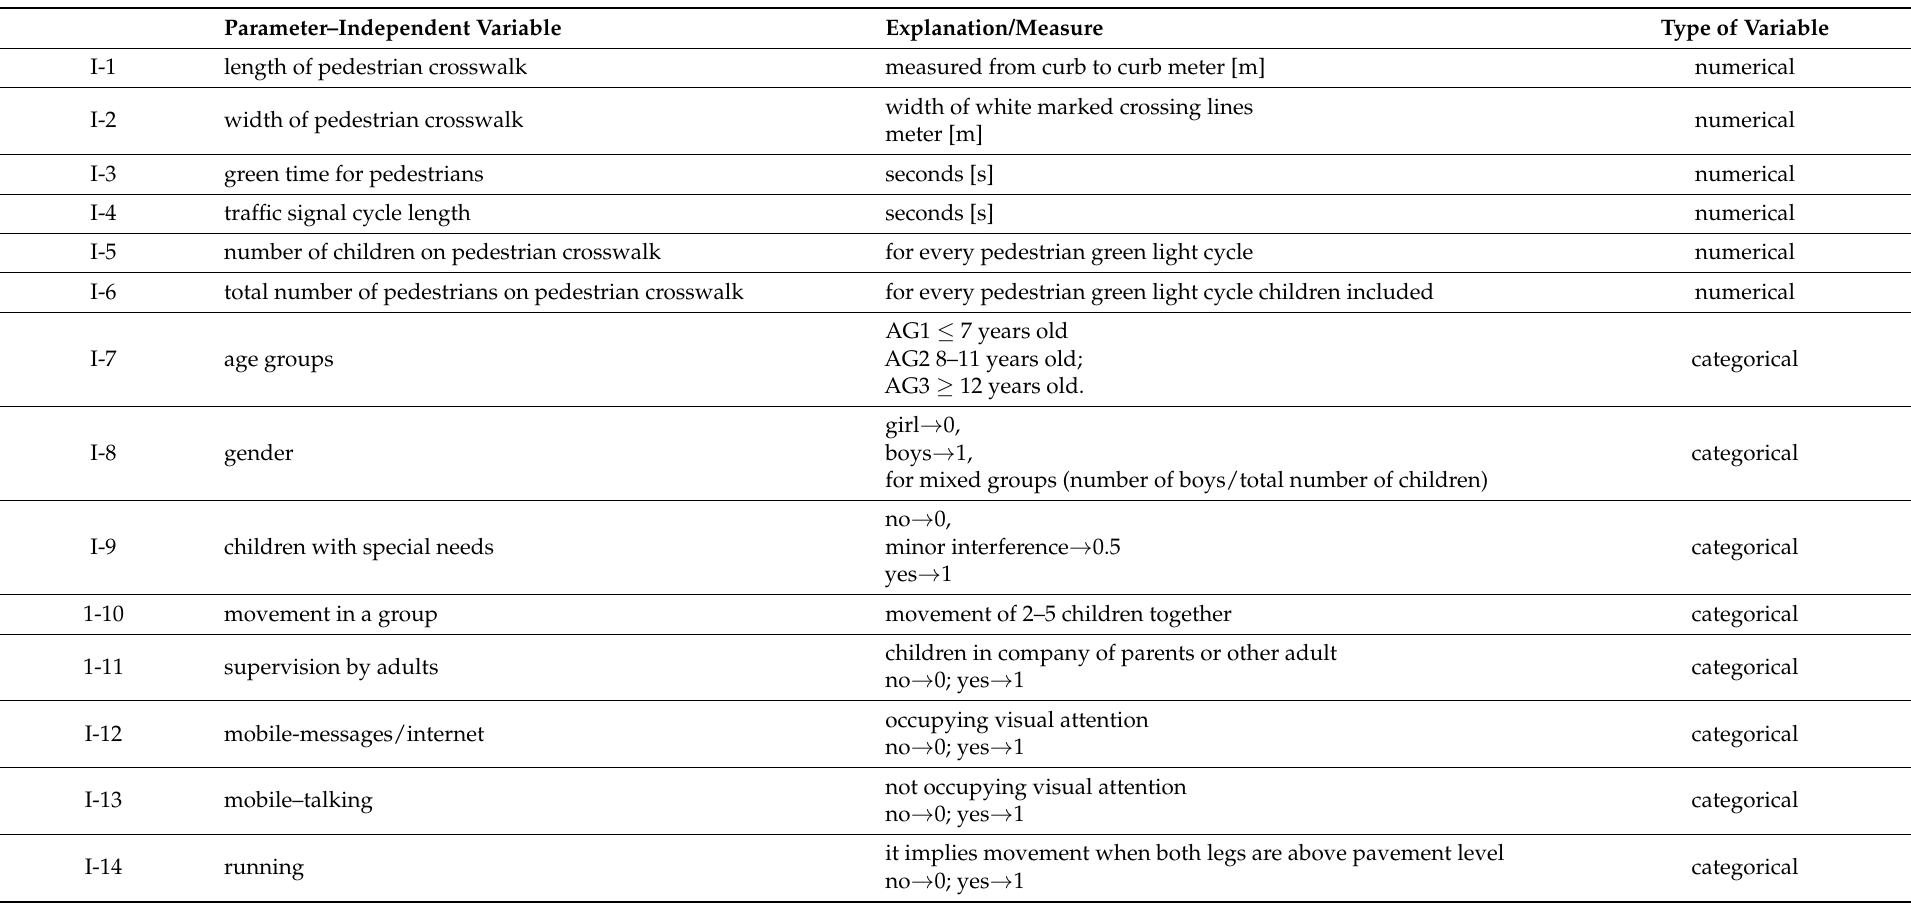
Table 4. Parameters